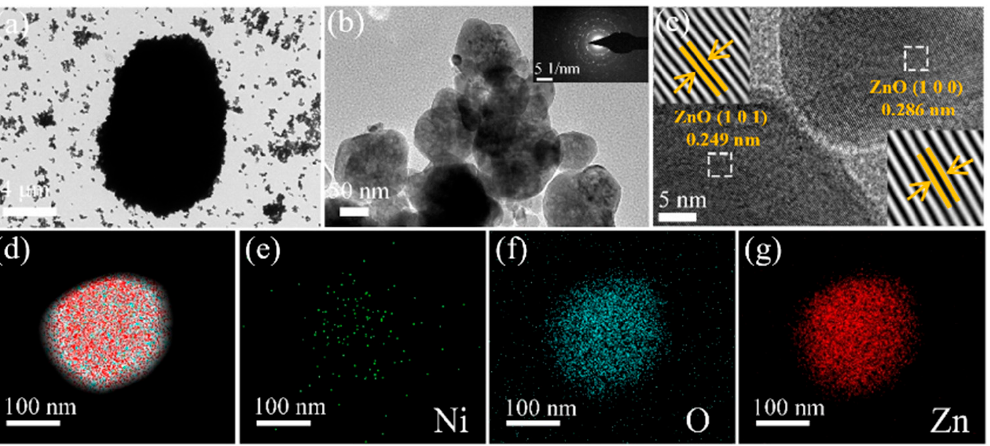
Figure 3. The TEM image of 1 at% Ni–ZnO ( a , b ). ( c ) HRTEM images of 1 at% Ni–ZnO. ( d ) The overlapped elemental mapping of Ni, O, Zn in the 1 at% Ni–ZnO sample, and ( e – g ) elemental mapping of Ni, O, and Zn.